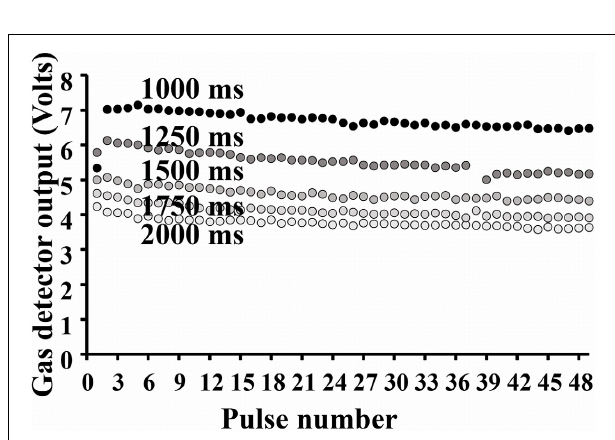
FIGURE 7 | Gas sensor output values for each of the 50 pulses as a function of the pulse